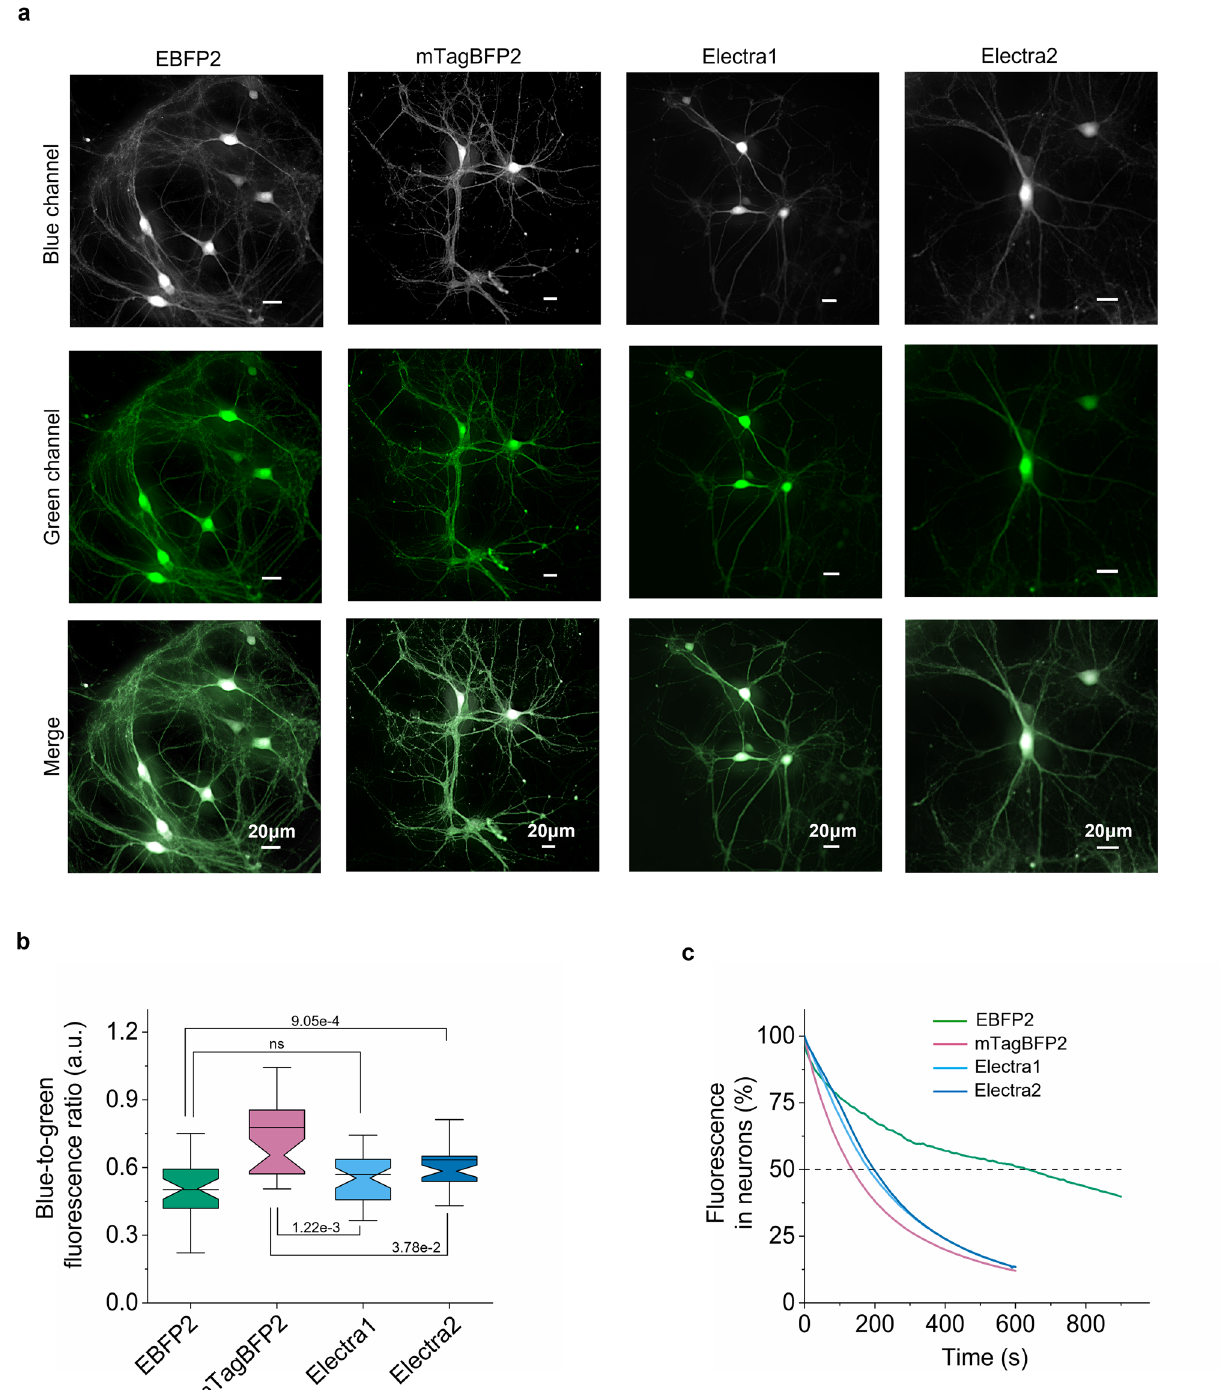
Figure 5. Characterization of Electra variants in cultured neurons. ( a ) Representative images of hippocampal neurons at DIV14 co-expressing EBFP2, mTagBFP2, Electra1, or Electra2 under human synapsin promoter with EGFP via P2A self-cleaving peptide. BFPs are shown in grey; EGFP in green ( n = 35, 37, 38, 40 respectively, from 2 independent rAAV2/9 transductions each; imaging conditions for BFPs: 403 nm excitation; 456 nm emission; 0.91 mW/mm 2 ; z-stack max projection; image deconvolution using NIS Elements online deconvolution tool). The dynamic range of all images was adjusted independently to facilitate visualization. (b ) Quantification of blue-to-green fluorescence ratio in live hippocampal neurons ( n = 35, 37, 38, 40 neurons for EBFP2, mTagBFP2, Electra1, Electra2, respectively, from 2 independent transductions each; Kruskal– WaNllis ANOVA p -value = 4.66e-8; post-hoc two sample Kolmogorov-Smirnoff p -values shown in graph; Supplementary Table S6). Box plots throughout same as in Fig. 2b. ( c ) Photobleaching curves for EBFP2, mTagBFP2, Electra1, Electra2 in live neurons under continuous wide-field illumination ( n = 8, 26, 32, and 26 neurons, respectively; imaging conditions of BFPs: continuous illumination under 403 nm LED, 3.72 mW/mm 2